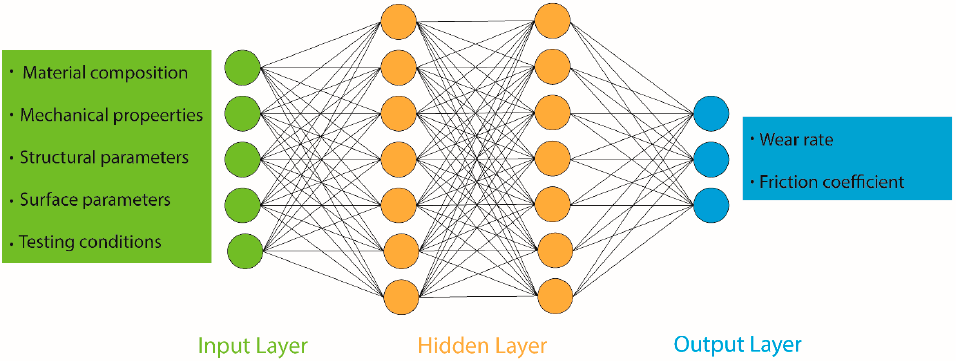
Figure 9. Typical architecture of an artificial neural networks used in tribology.